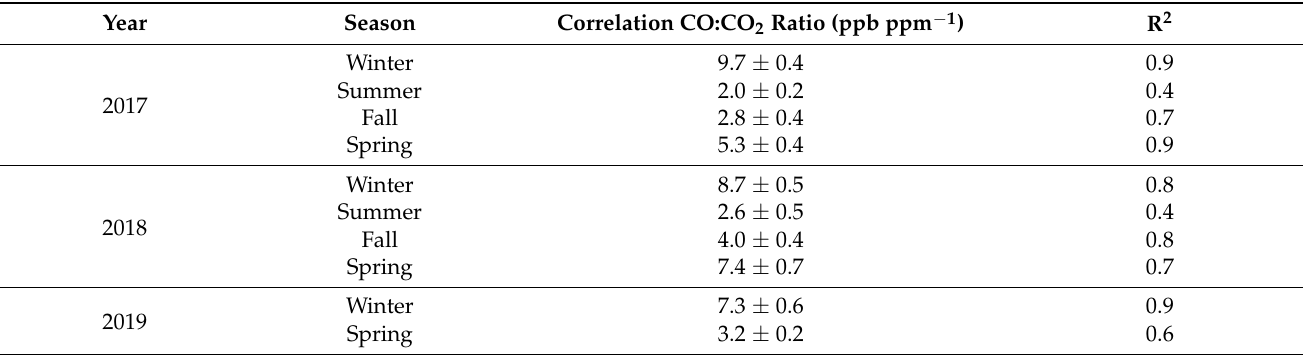
Figure 2. Daytime and nighttime mean mixing ratio values of CO 2 and CH 4 . The daytime background mixing ratio values are shown in blue, and nighttime mean background values are shown in red. Table 1. Seasonal CO:CO 2 correlation ratios ( β − 1 ) in units of ppb ppm − 1 observed between 2017 and